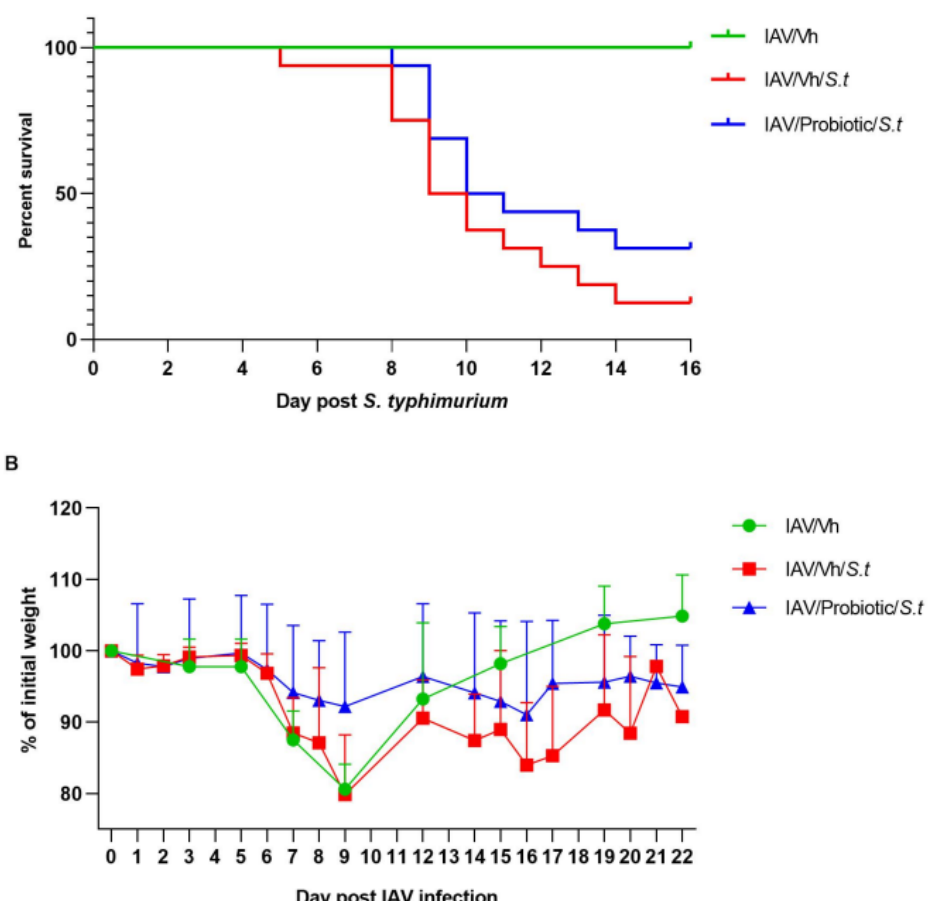
Figure 5. Effect of B. faecis DSM33383 supplementation during IAV infection on secondary Salmonella infection. IAV-infected mice (7 d.p.i.) were infected with Salmonella enterica serovar Typhimurium ( S.t ) (1 × 10 4 CFU). IAV-infected mice were gavaged or not (Vh) with B. faecis DSM33383 (5 × 10 6 CFU/200 µ L) at 2 d.p.i. until 7 d.p.i. ( A ) The survival and ( B ) body weight evolution (right) (in % initial body weight) of doubly infected animals, treated or not, were monitored ( n = 16, two pooled